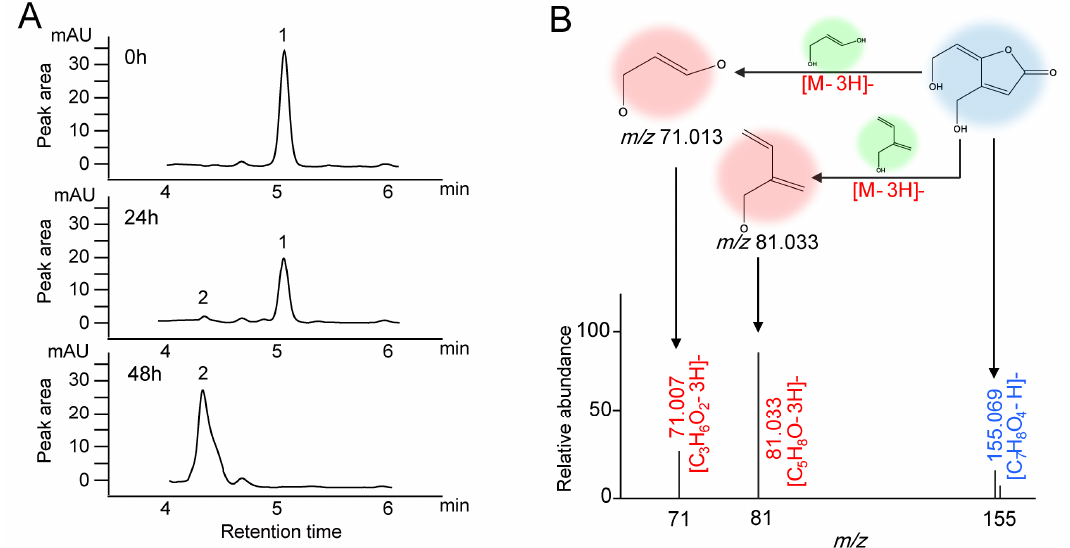
Figure 2. Chromatograms and mass spectra of patulin and suspected degradation products produced by A. niger FS10. ( A ) Time-course HPLC-UV of patulin removed by A. niger FS10 over 0 h, 24 h, and 48 h. ( B ) Mass spectra of suspected degradation products produced by A. niger FS10.